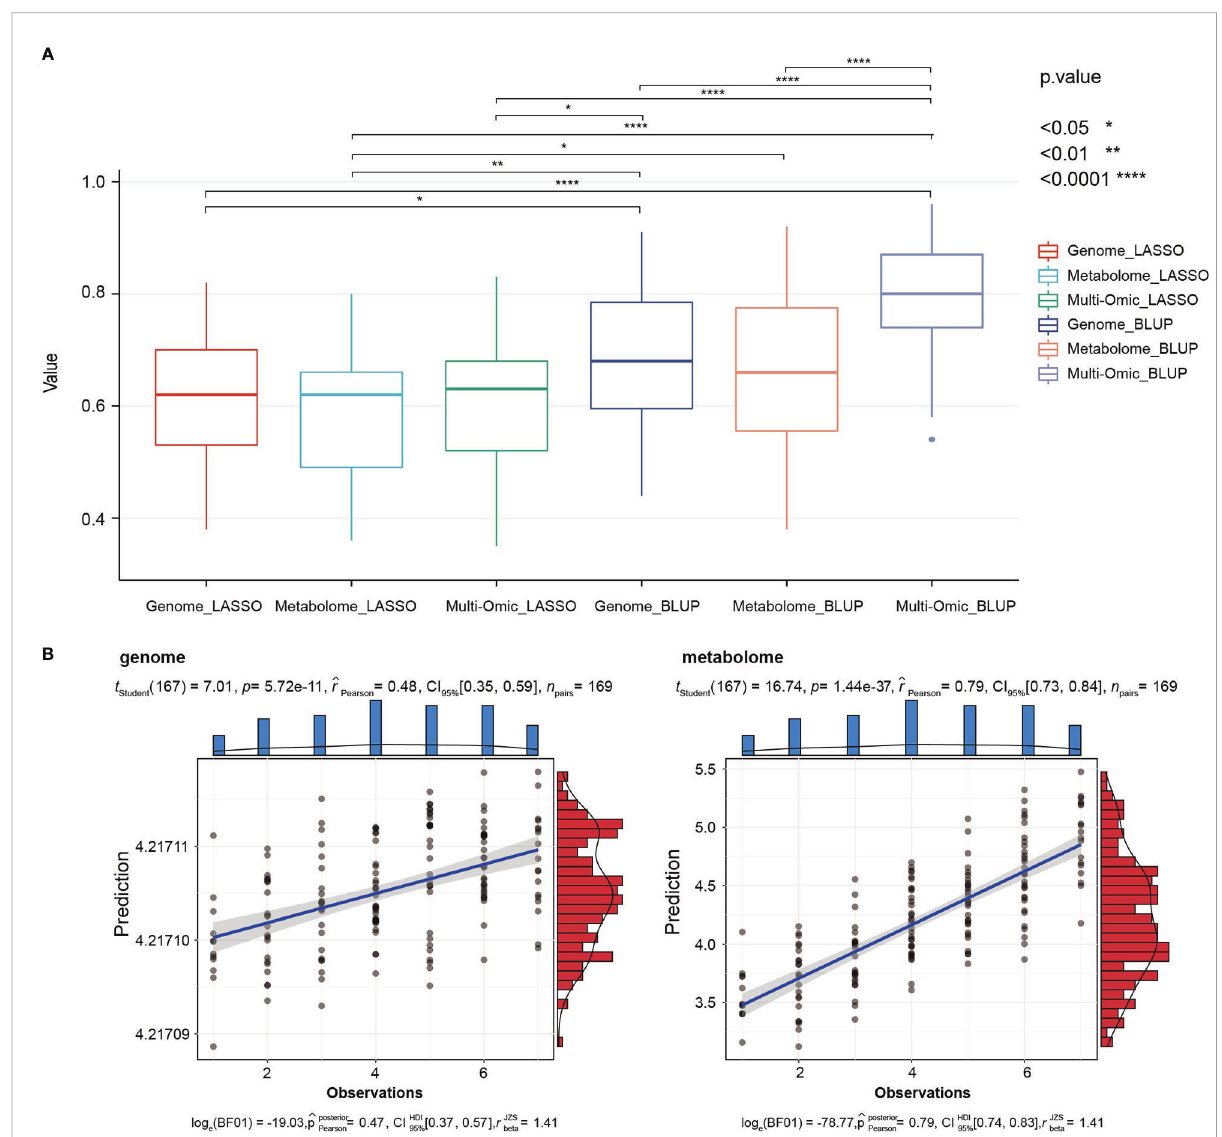
FIGURE 7 Predictabilities of 63 traits from three omic data (genomic, metabolomic and multi-omics) and two methods (LASSO, BLUP) in the RIL population. (A) Box plots compare the prediction results of the two methods for different omics data. In each box-plot, the line in the middle of the box represents the median. (B) The predictability of low-heritability phenotypes (TPN_2016) based on BLUP model using genomic (left) and metabolomic (right) data were displayed by correlation scatter